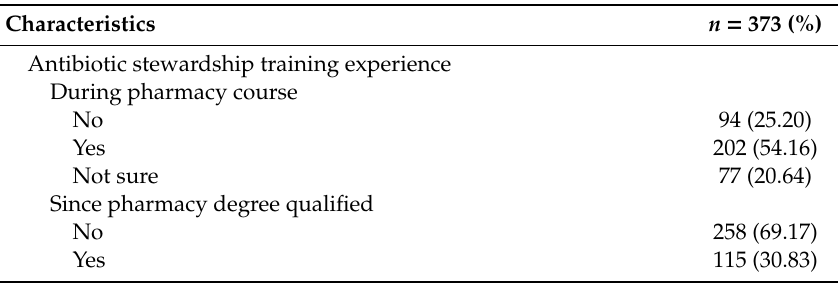
Table 7. Antibiotic Stewardship Training